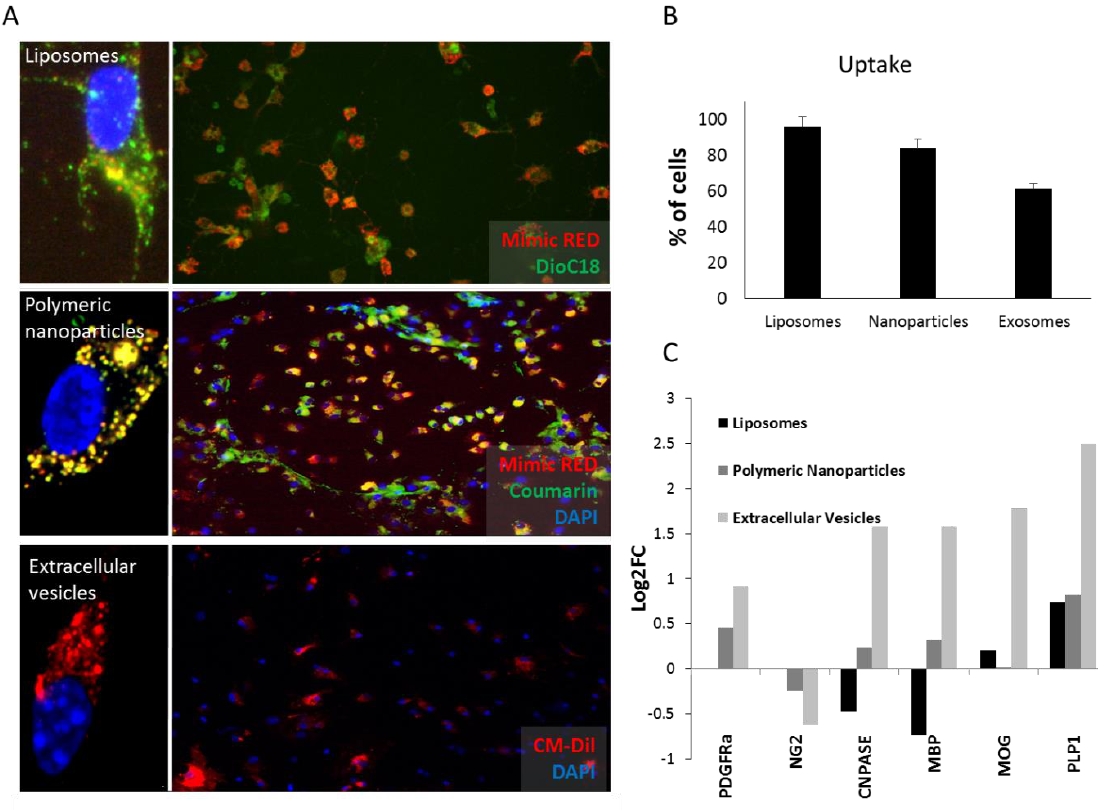
Figure 3. Up-take and di ff erentiation levels of oligodendrocyte precursor cells (OPCs) after vehicles administration. ( A ) Uptake studies of liposomes, polymeric nanoparticles and extracellular vesicles. Liposomes containing 3,3 (cid:48) -Dioctadecyloxacarbocyanine perchlorate dissolved in chloroform (1mg / mL) (DOiC)18 (green) and mimic-Red (red), nanoparticles containing Coumarin (green) and mimic-Red (red) and EVs labelled with CM-DiL (red) are shown. Dapi (blue) was used to stain nucleus. Individual cells are imaged by confocal fluorescence microscopy of representative samples. ( B ) Percentage of OPCs that are able to take up each vehicle. Liposomes are the most e ffi cient vehicle followed by polymeric nanoparticles and finally EVs. ( C ) Expression levels (expressed as de logarithm 2 of the fold change; Log2FC) of myelin related genes in OPC cultures treated with each vehicle compared to the same empty vehicle. EVs are the only vehicle able to induce OPC di ff erentiation. Note the lack of PDGFRa and NG2 data in liposomes due to technical